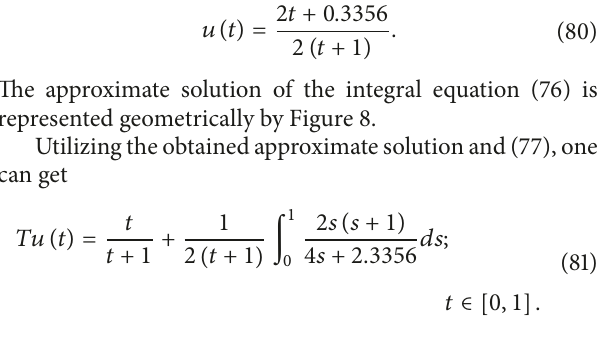
Figure 10: Error between solution and integral